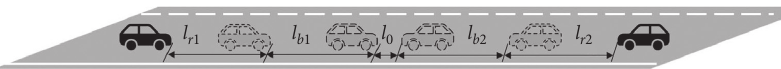
Figure 5: Configuration of a no-entry section.